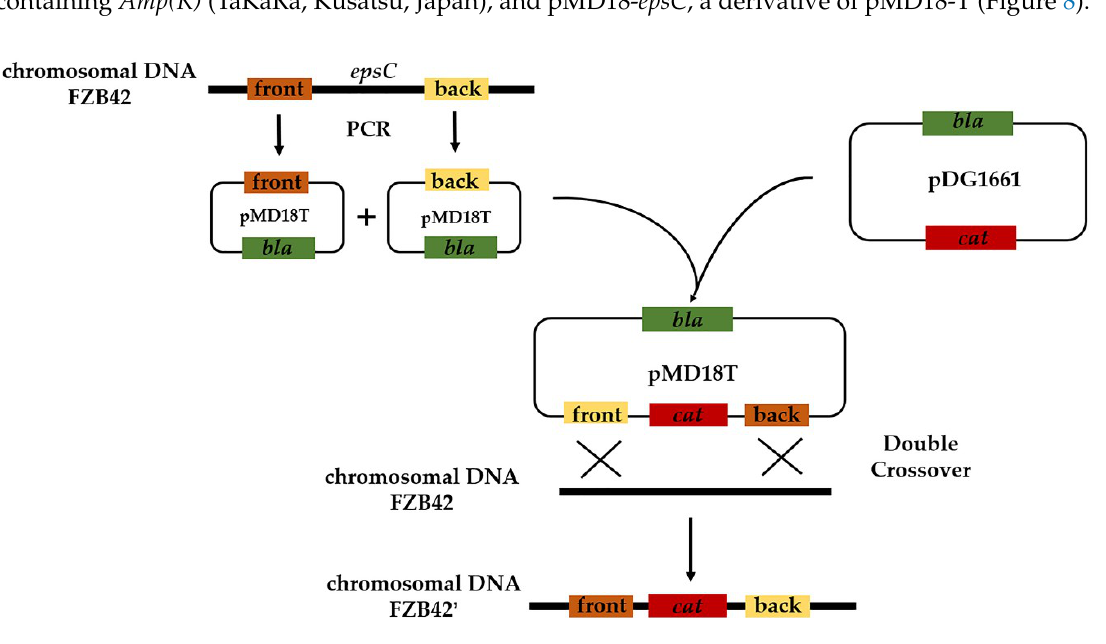
Figure 8. Construction of epsC double‐crossover deletion mutants.